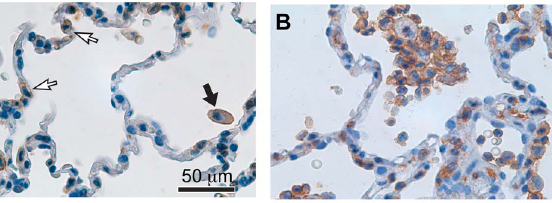
Figure 3. Integrin a D b 2 is expressed by leukocytes in human lung. A. Tissue samples from a human subject with normal lungs who underwent autopsy after fatal head injury were fixed and stained for a D with mAb 169A as outlined in Materials and Methods and [34]. Microscopic evaluation revealed a D b 2 + macrophages in alveolar spaces (black arrow). There are also scattered a D + cells in alveolar walls (white arrows), which may be interstitial macrophages and/or dendritic cells. This image is representative of findings from analysis of lung tissue from three subjects who died without lung disease or injury. B. Autopsy samples from a patient who died with acute respiratory distress syndrome [34,45] were fixed, stained for a D , and examined by light microscopy. Numerous a D b 2 + macrophages were detected in alveolar spaces and walls. In some fields a D b 2 + neutrophils were also present (not shown). Lung samples from 3 patients who died with acute lung injury or ARDS as defined by consensus criteria [44] were examined. We found a D b 2 + leukocytes in the alveoli in each